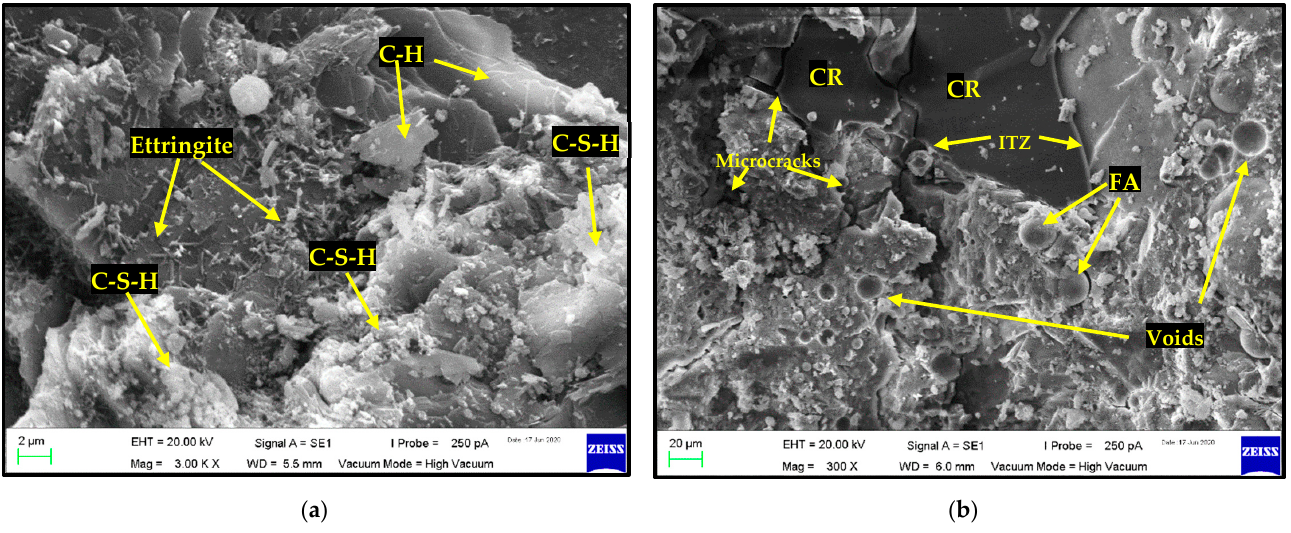
Figure 11. ( a ) Formation of primary and secondary hydration products due to FA and NS. ( b ) Presence of voids and microcracks in a mix having CR.